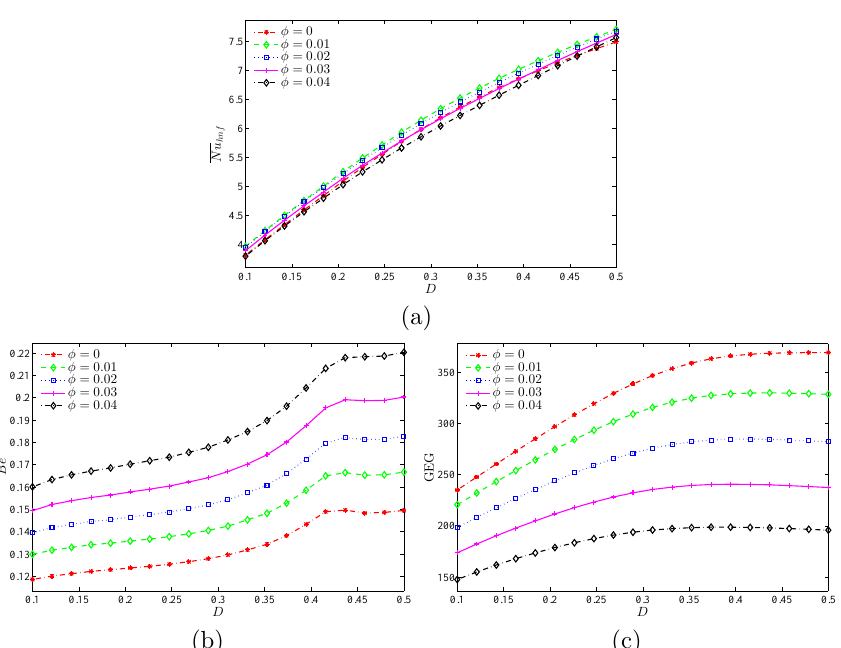
Figure 16. Evaluation of ( a ) average Nusselt number ( Nu ), ( b ) Bejan number ( Be ), and ( c ) the global entropy generation (GEG) with D and different φ for hybrid nanofluids and Ra = 10 5 .